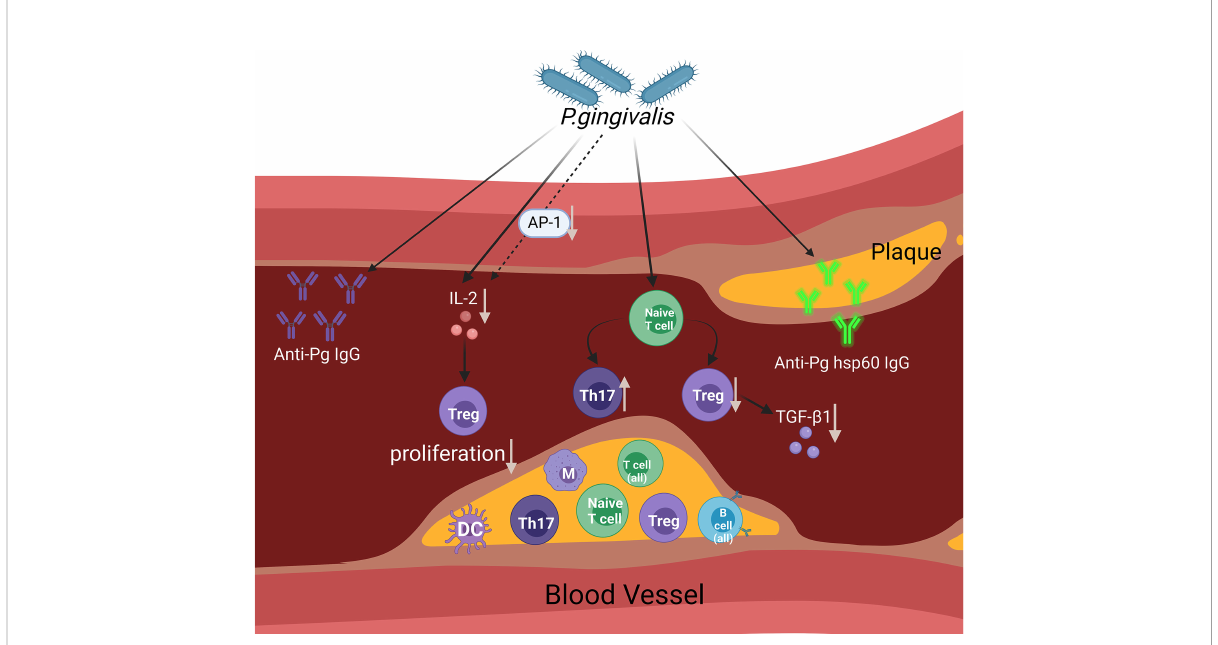
FIGURE 1 This fi gure aims to display the presumed contribution of P. gingivalis to atherosclerosis via the regulation of the adaptive immune system. The fi gure shows a diagram of an open blood vessel affected by atherosclerotic plaque. Within the diagram, we can see that there are different types of immune cells affected in the blood vessels and atherosclerotic plaques. As infection rises within the blood vessels caused by P. gingivalis , the Th17/Treg cell population becomes imbalanced (an increase in the Th17 cell population and a decrease in the Treg cell population) and reduces TGF- b 1 levels. In reaction to P. gingivalis , AP-1 transcription factor activity was reduced. The accumulation of IL-2 is in fl uenced by P. gingivalis and partially affects the suppression of AP-1, which affects Treg proliferation. The involvement of adaptive immune responses of the host is proven by the evidence of increased anti-Pg lgG and anti-Pg hsp60 lgG. (Created with